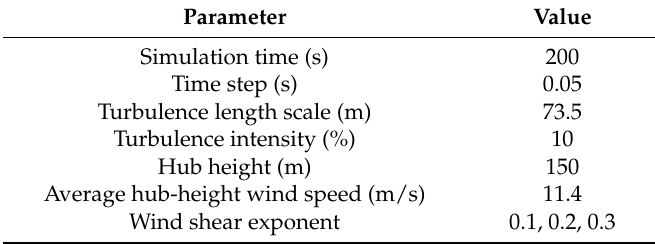
Table 1. The values of the main parameters in the GP_LLJ spectral model. GP_LLJ: Great Plains Low-Level Jet (LLJ). Table 2. The values of the main parameters in IEC Von Karman isotropic spectral model.